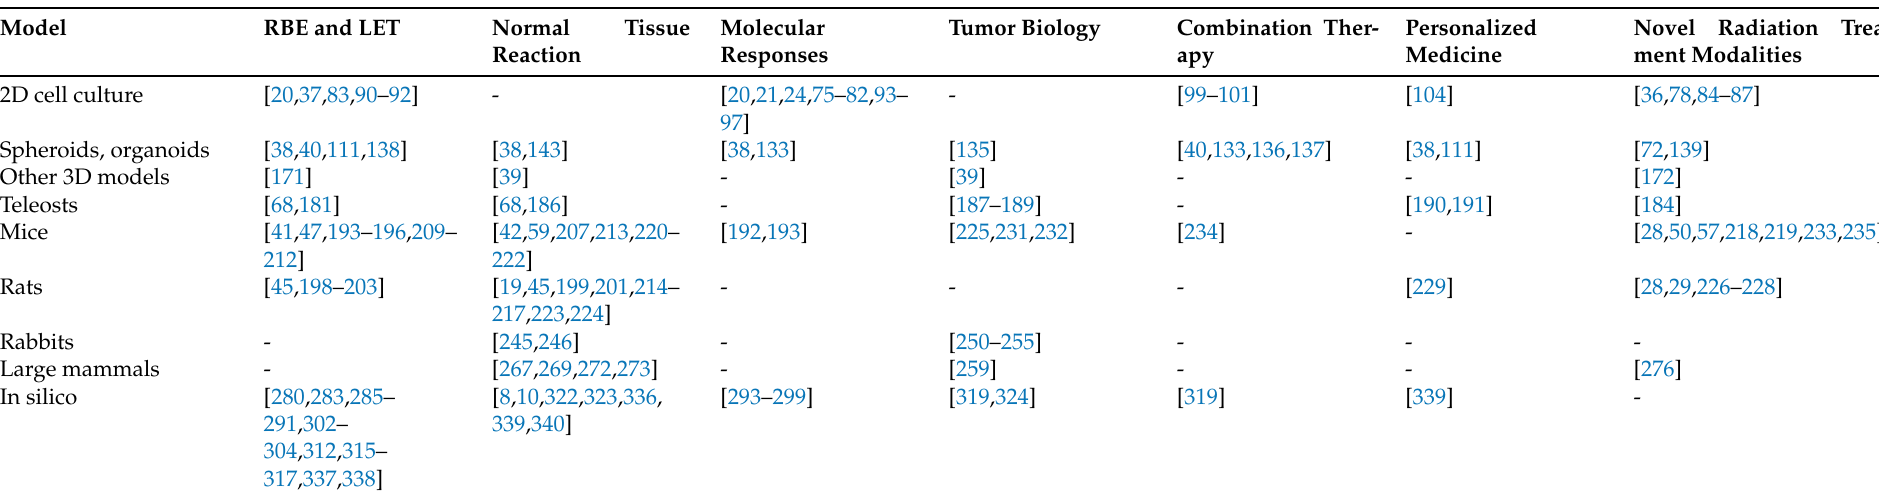
Table 1. Literature overview of preclinical models for investigations of proton-specific research